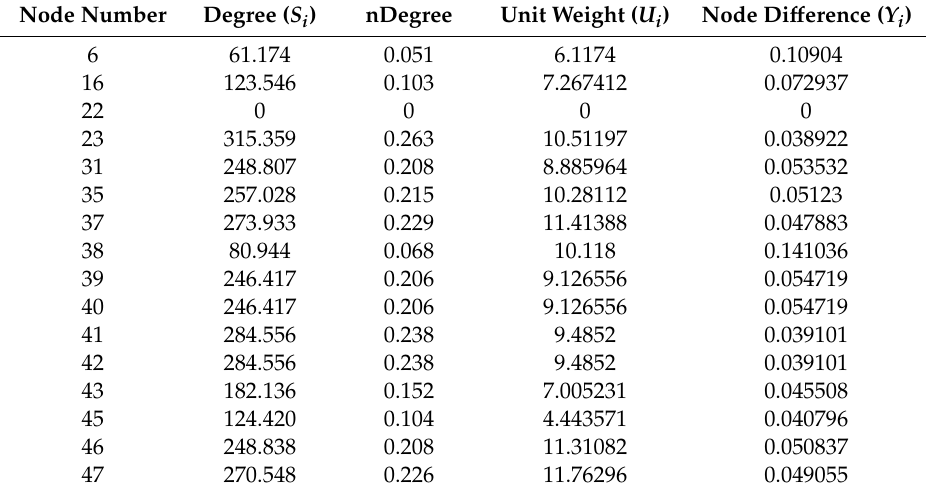
Table 5. Node strength, unit weight and node di ff erence of the air transportation weighted network. Node Number